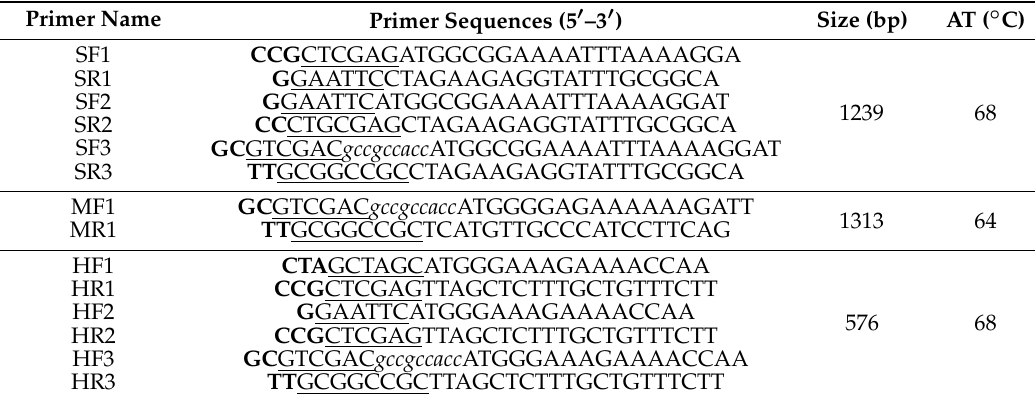
Table 1. Primers used in in the construction of expression vectors of porcine Suv39h1